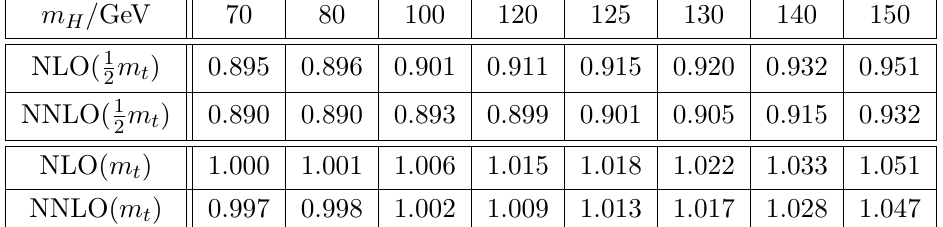
Figure 5. Renormalization scale dependence of the LO (dot-dashed blue line), NLO (dashed orange line) and NNLO (green line) partial decay width of a top quark decaying into a 100 GeV charged Higgs boson and jets. All the results are normalized to the LO partial width at central scale µ R = m t . The Monte-Carlo uncertainties are very small and are not shown here.